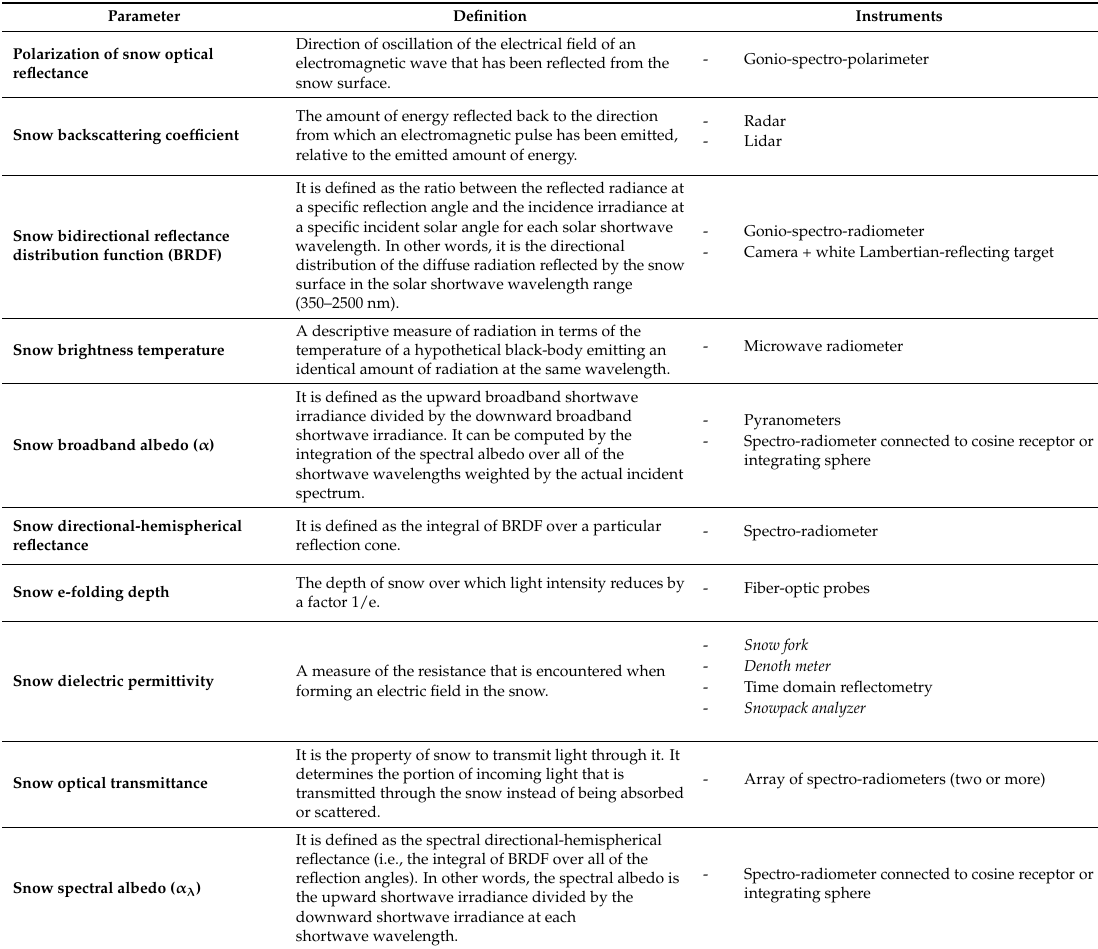
Table A3. List of measurable snow electromagnetic properties: name of the properties (first column), definition (second column), and existing